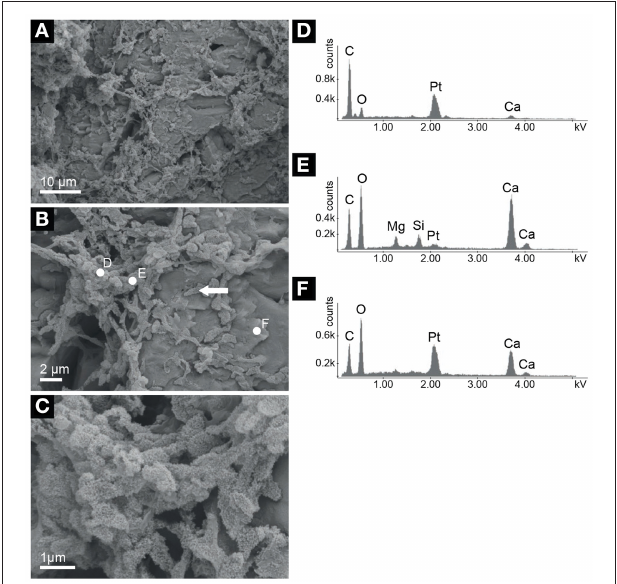
FIGURE 3 | Scanning electron microscopy (SEM) photomicrographs of the mushroom cap. (A) Overview showing the presence of a matrix made of filamentous microstructures associated with the calcite crystals. (B) Detail of (A) showing filaments that we interpret as fossilized extracellular polymeric substances (EPS). Oval structures (arrow) may be microbial cells or EPS aggregates. (C) Detail of (B) showing nanoglobules forming on the EPS/putative cells microstructures. (D–F) Energy dispersive X-ray spectra relative to measurements performed on the sites indicated in (B) , which show different stages of mineralization of the putative cells and EPS filaments from mainly organic features (D) to calcium carbonate (F) . The intermediate stage of mineral growth on the organic microstructures (E) is characterized by a phase that also includes Mg and Si. Pt peaks correspond to coating applied during sample preparation.